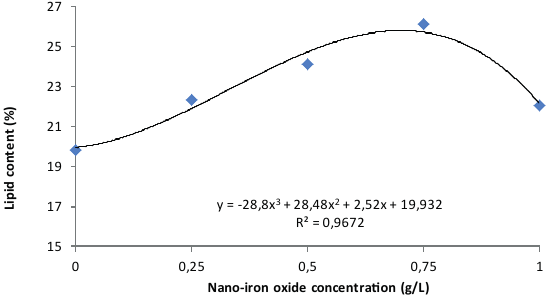
Figure 2- The effect of different concentrations of nano-iron oxide on soybean seed lipid